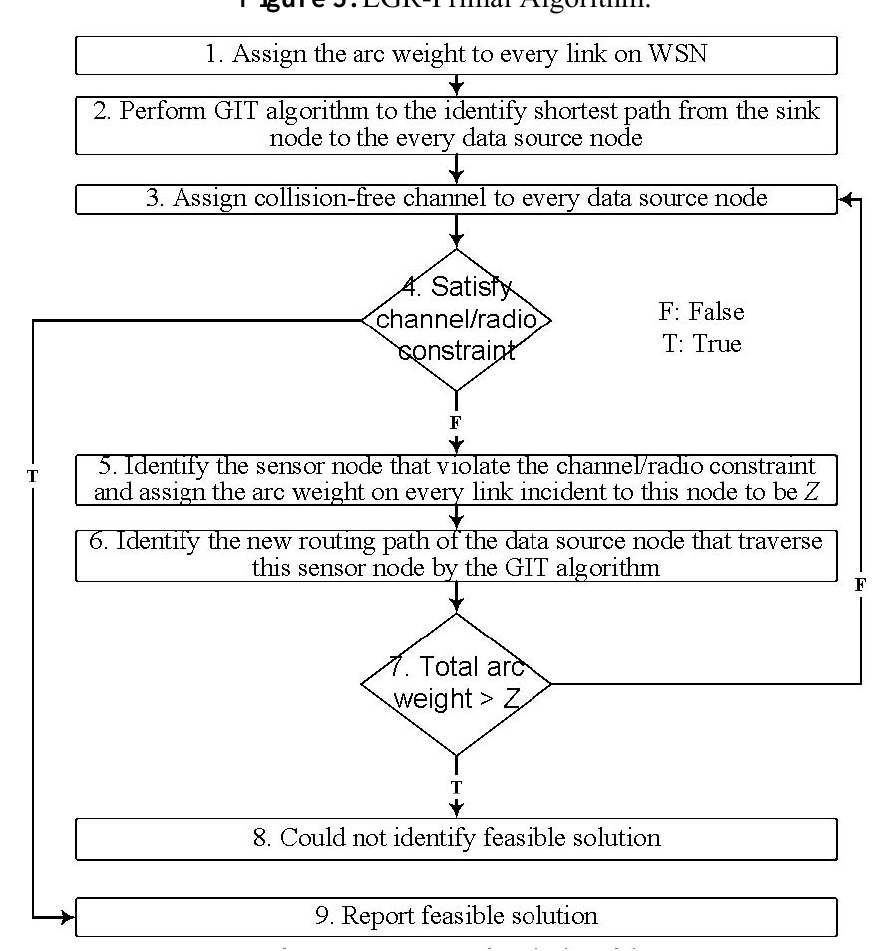
Figure 5. LGR-Primal